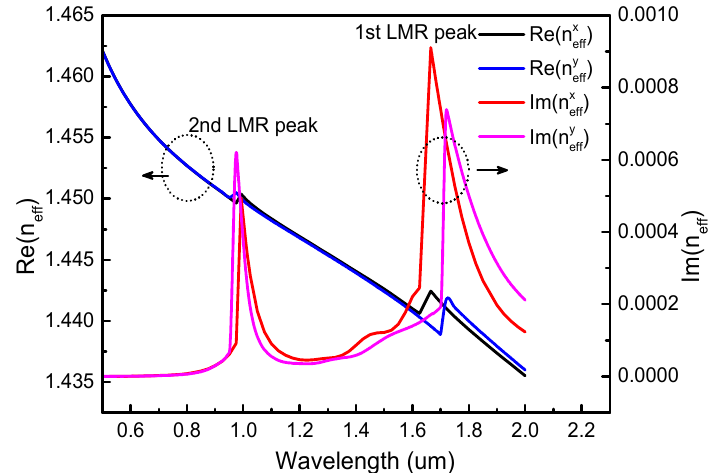
Figure 2. Dispersion relations of effective index of core mode at analyte refractive index (RI) n a = 1.33.